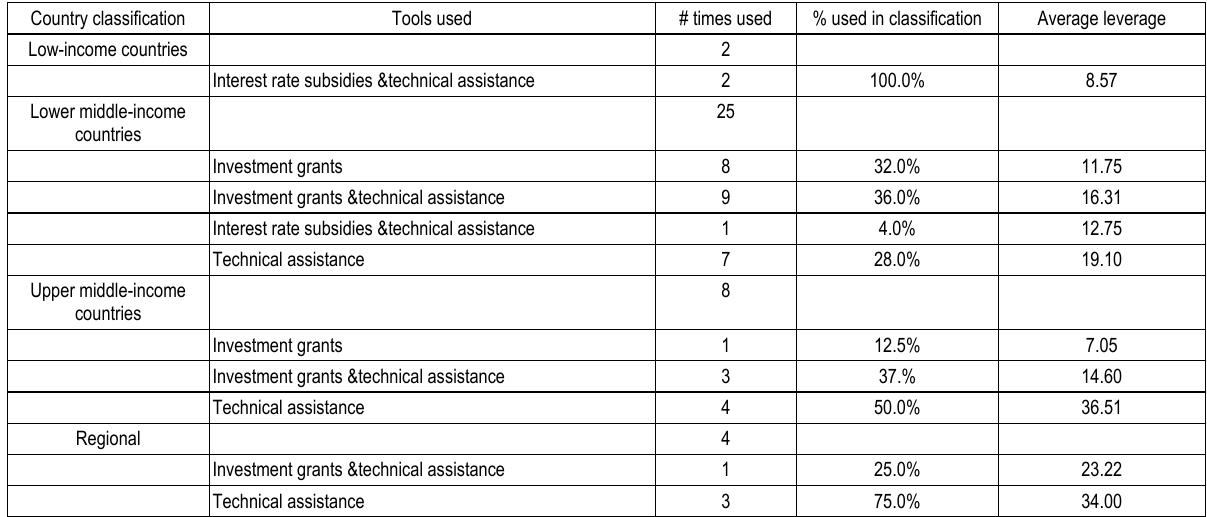
Table 3. Breakdown of financing tools as per economic country